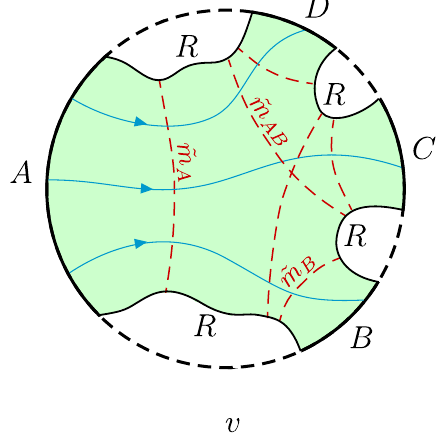
Fig. 2 The vector field v is defined on M (cid:9) , the region surrounded by A ∪ B ∪ C ∪ D ∪ R ,aswehaveimposedano-fluxconditiononsurface R . And ˜ m A , ˜ m B and ˜ m AB are the minimal surfaces homologous to regions A , B and AB relative to R ,